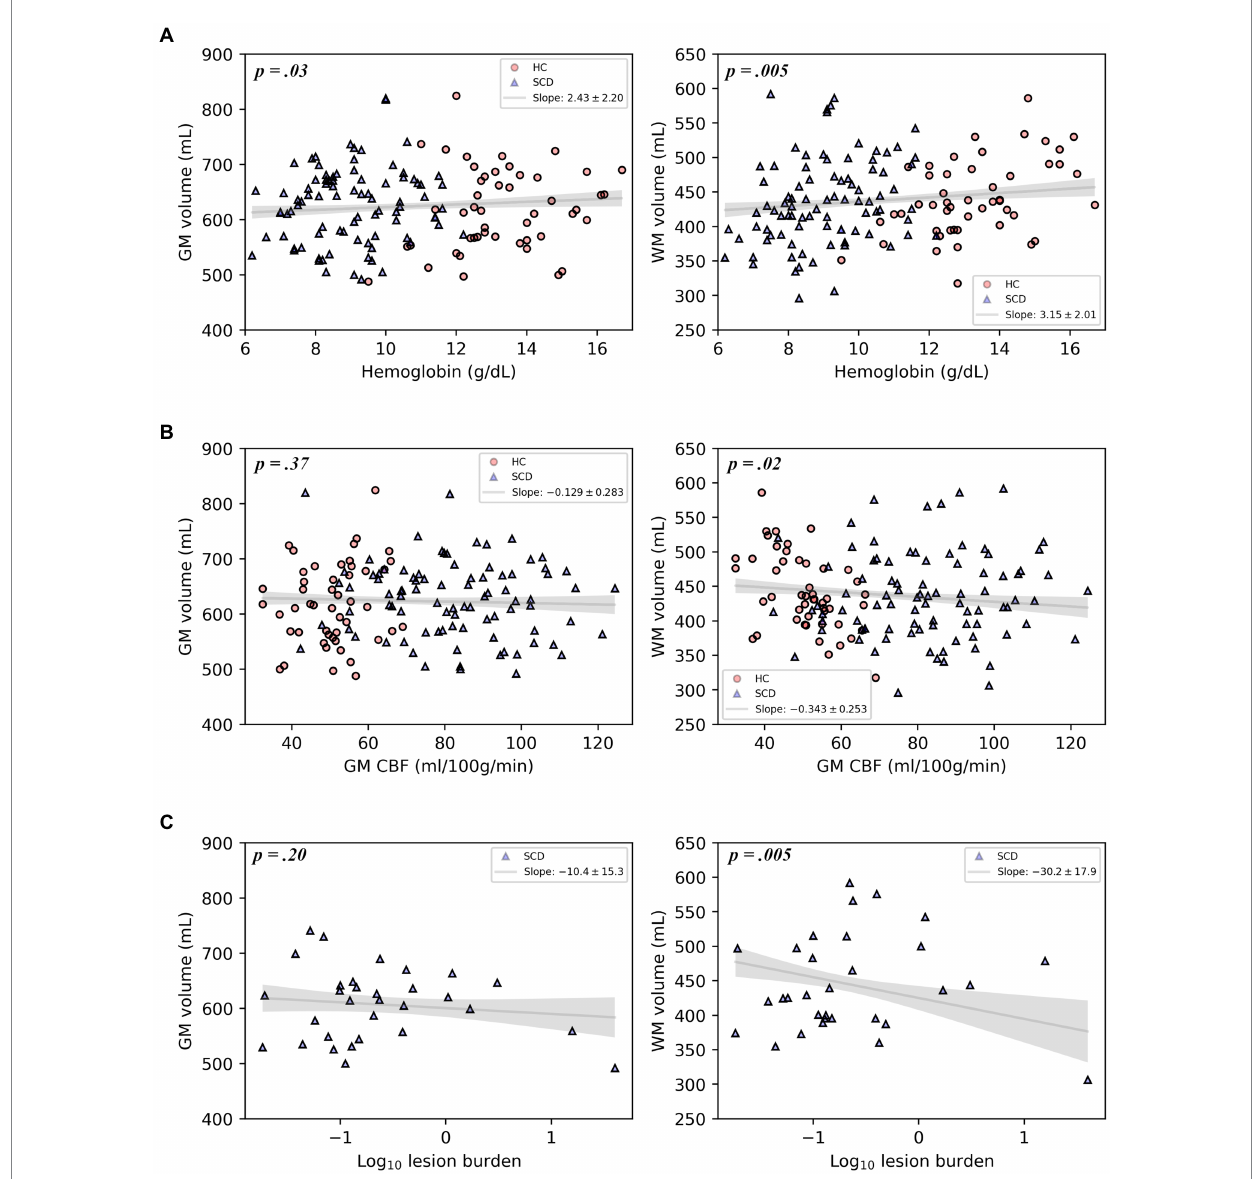
FIGURE 3 Plots of gray matter volume and white matter volume with hemoglobin, gray matter CBF, or log-transformed infarct (lesion) burden, displaying the multivariable regression model-predicted association between each covariate and volume, controlling for age, sex, and intracranial volume, with 95% confidence intervals (gray line and shaded area). Models include healthy controls and participants with SCD (A,B) or participants with SCD and silent cerebral infarcts only (C) . Overlaid on the model predictions are the raw